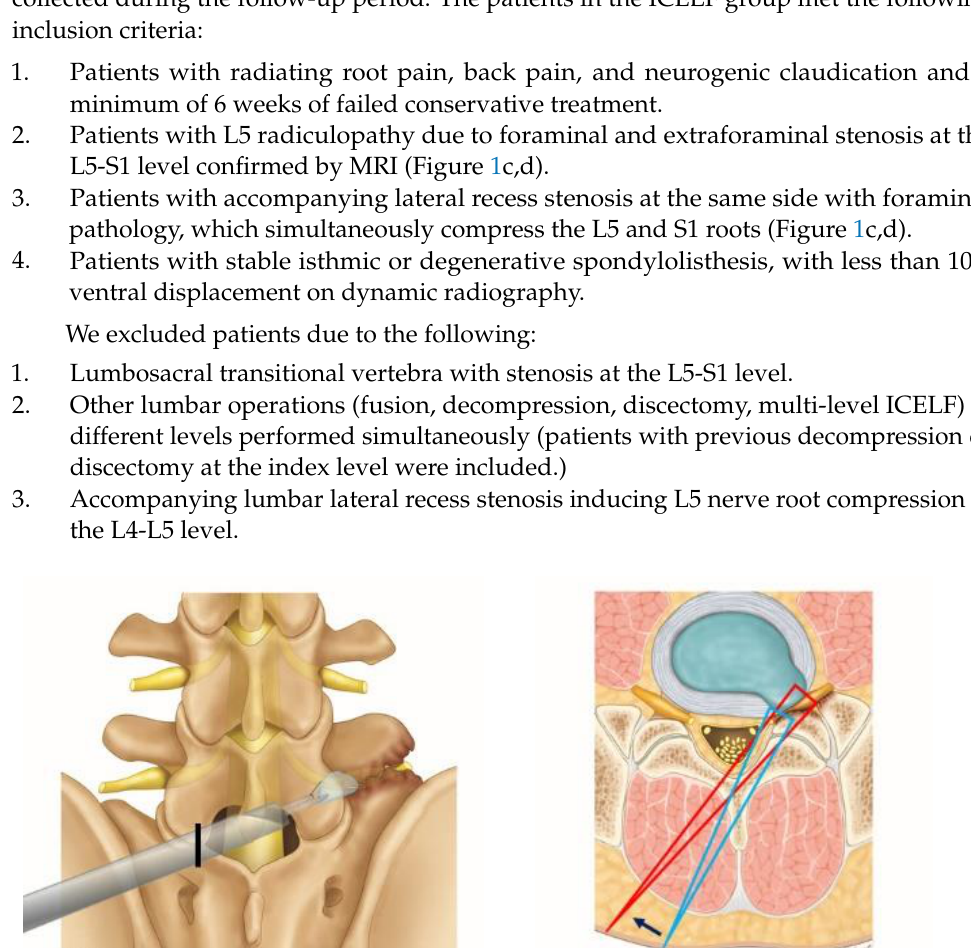
( d ) Figure 1. Illustration of the surgical approach for the coexisting intra-and-extraspinal root compression lesions at the L5- S1 level. ( a ) The surgical route of interlaminar contralateral endoscopic lumbar foraminotomy (ICELF) on a lumbar spinal model. The black line showed the skin incision point. ( b ) The trajectory of ICELF on the axial plane. Lateral recess decom- pression and medial foraminal opening were performed with an initial approaching trajectory (long blue triangle. The trajectory was then changed to a lower angle by levering the endoscope (long red triangle) to reach the foraminal and extraforaminal space. ( c , d ) Multifocal nerve root compression lesions at the intra-and-extra spinal canal are shown on the magnetic resonance imaging at the lateral recess (thin arrows), foraminal region (broad arrows), and extraforaminal region (arrowheads). All the indicated lesions could be resolved with one direction approach. 1. Patients with radiating root pain, back pain, and neurogenic claudication and a min- imum of 6 weeks of failed conservative treatment. 2. Patients with L5 radiculopathy due to foraminal and extraforaminal stenosis at the L5-S1 level confirmed by MRI (Figure 1c,d). 3. Patients with accompanying lateral recess stenosis at the same side with foraminal pathology, which simultaneously compress the L5 and S1 roots (Figure 1c,d). 4. Patients with stable isthmic or degenerative spondylolisthesis, with less than 10% ventral displacement on dynamic radiography. We excluded patients due to the following: 1. Lumbosacral transitional vertebra with stenosis at the L5-S1 level. 2. Other lumbar operations (fusion, decompression, discectomy, multi-level ICELF) at different levels performed simultaneously (patients with previous decompression or discectomy at the index level were included.) 3. Accompanying lumbar lateral recess stenosis inducing L5 nerve root compression at the L4-L5 level.